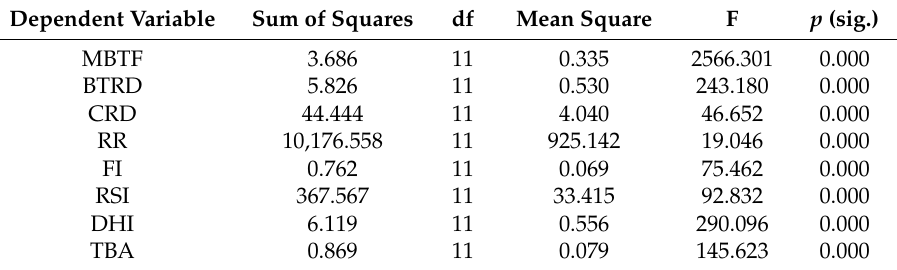
Table 4. One-way ANOVA analysis results of the evaluation